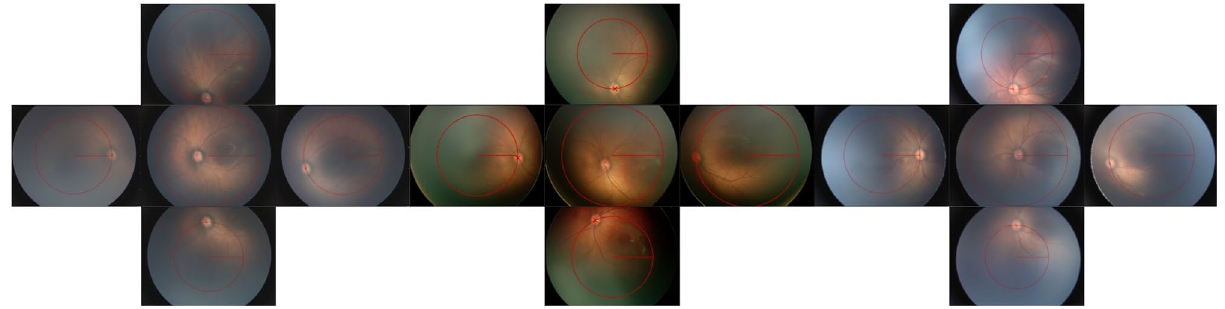
Figure 1. Illustration of how the radius in each photo of a session was measured. The red X represents the optic disc marked as reference for the